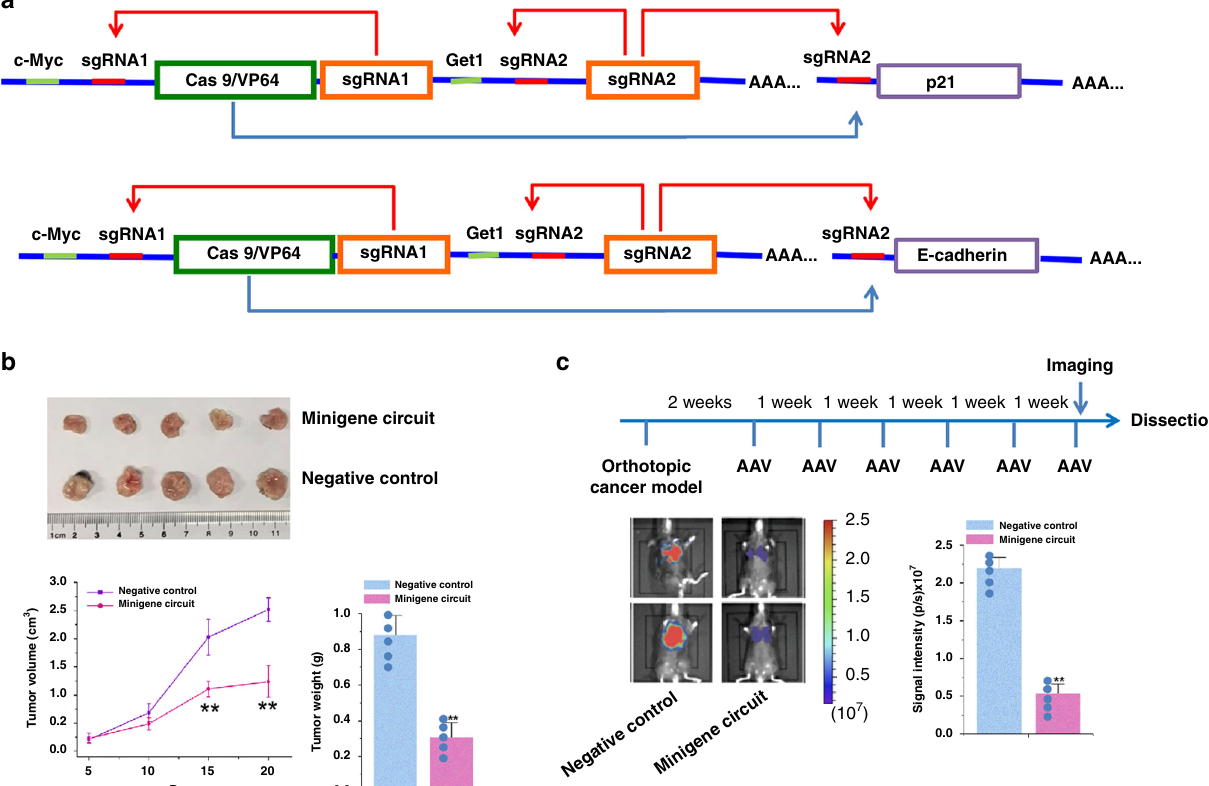
Fig. 5 Minigene circuits speci fi cally and ef fi ciently inhibited in vivo tumor growth and metastasis. a The design of minigene circuits targeting cellular genes p21 and E-cadherin. Among them, p21 and E-cadherin are located on the recipient cell genome, while other components are located on the AAV vector. b The tumor volume was calculated once every 5 days after injecting AAVs. The minigene circuit with sgRNA control that had no targeted intracellular gene was used as the negative control circuit. Tumors treated with the minigene circuit ( n = 5 animals) targeting p21 were dramatically smaller than those treated with the negative control ( n = 5 animals). Data are shown as means of tumor weight± SD. The small blue dots represent the weight of each sample. ** p < 0.01, relative to the negative control using the two-tailed t -test. Exact p- values for asterisks (from left to right): 0.0006, 0.0004, and 0.037. Source data are provided as a Source Data fi le. c Quanti fi cation for bioluminescence imaging of a metastatic model. The minigene circuit with sgRNA control that had no targeted intracellular gene was used as the negative control circuit. The luminescent signal intensities for either minigene circuit targeting E-cadherin ( n = 5 animals) or negative control circuit ( n = 5 animals) are shown. Only tumors in lung regions were quanti fi ed by intraperitoneal D-luciferin administration, and then the signal intensities in lungs were calculated. The small blue dots represent the mean signal intensity of each mouse. ** p < 0.01 ( p = 0.029), relative to the negative control using the two-tailed t -test. AAV adeno-associated virus. Source data are provided as a Source Data fi